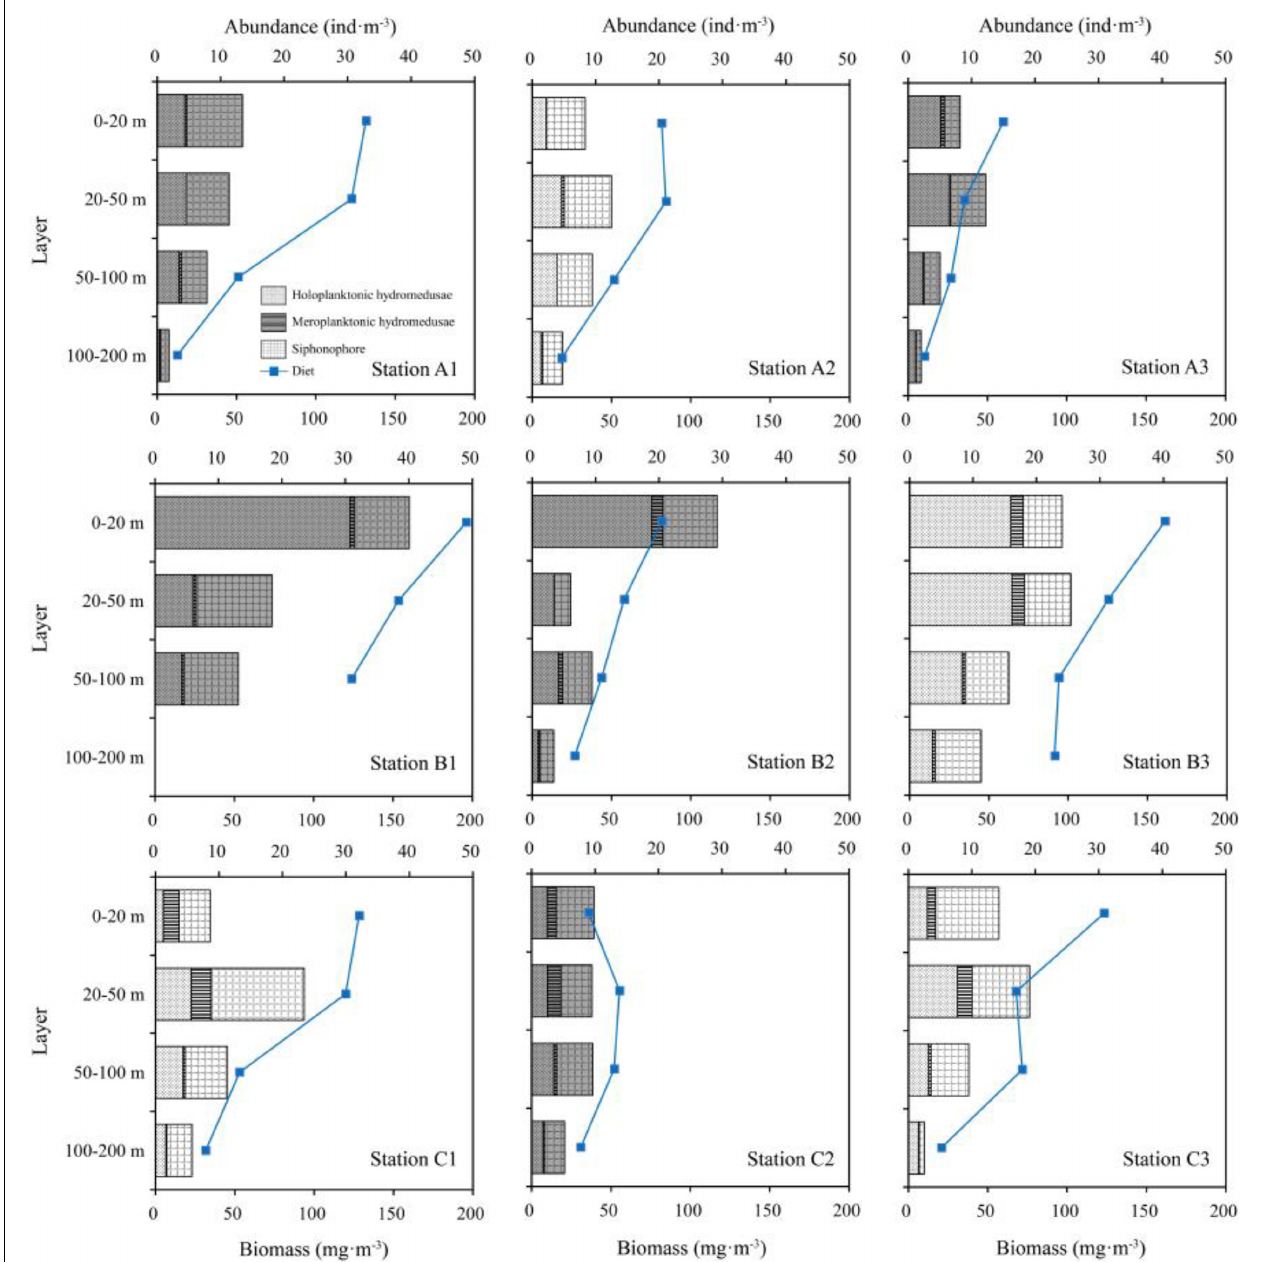
FIGURE 5 | Vertical distribution of medusae abundance and wet weight biomass of diet at each station (white, daytime; gray, nighttime). Blue dots mean the wet-weight biomass of diet